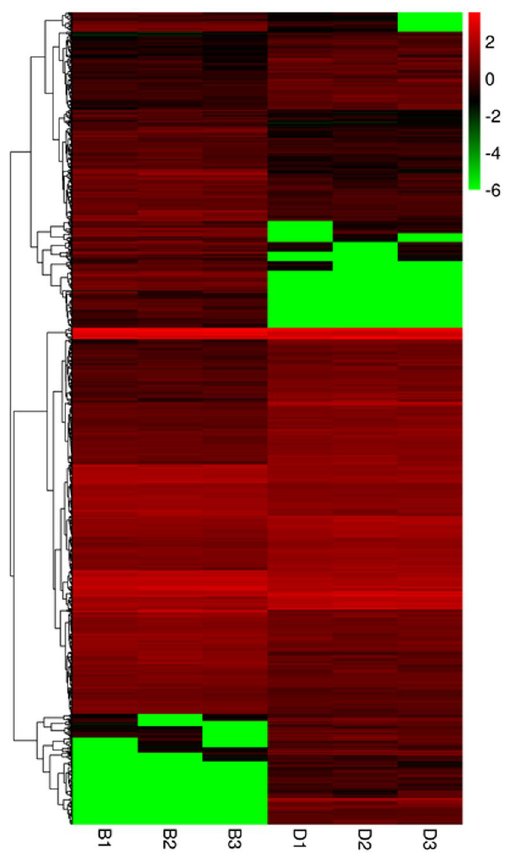
Figure 5. Heat map of differentially expressed genes based on a hierarchical cluster analysis. Green represents the lowest expression level; black indicates intermediate expression levels and red represents the highest expression levels. A color scale bar for log-transformed FPKM is shown at the top-right of the figure. B1, B2, and B3 represent three biological replicates from the B plants; likewise, D1, D2, and D3 are biological replicates from the D